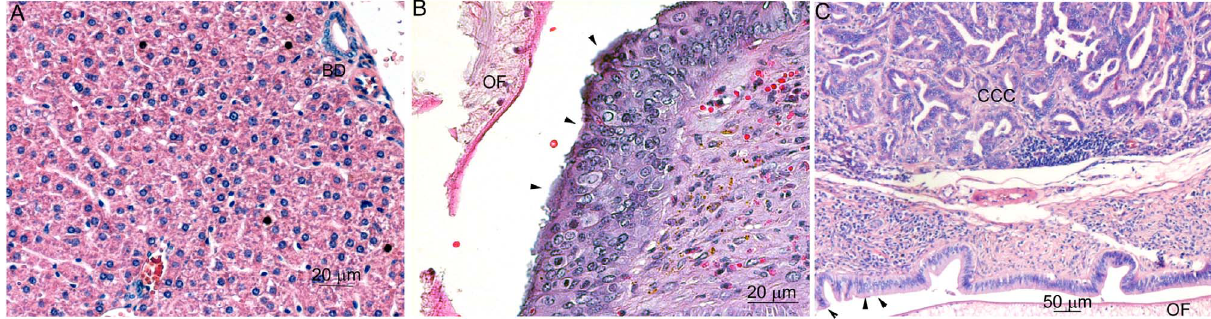
Figure 3. Biliary histological features in the liver biopsies from hamsters with the experimental opisthorchiasis felinea. (A) Intact animal. (B) High-grade biliary neoplasia caused by O. felineus three months p.i. (C) Cholangiocarcinoma in the liver of hamster as a result of a combined action of O. felineus and dimethylnitrosoamine, three months p.i. BD, bile duct; OF, O. felineus ; CCC, cholangiocarcinoma. High-grade biliary neoplasia is indicated with arrows. Pictures 3A and 3C were kindly provided by Maksimova